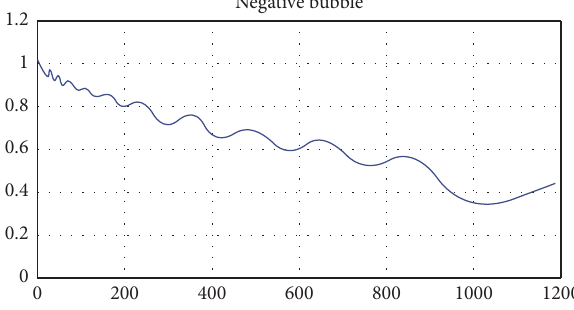
Figure 4: Negative